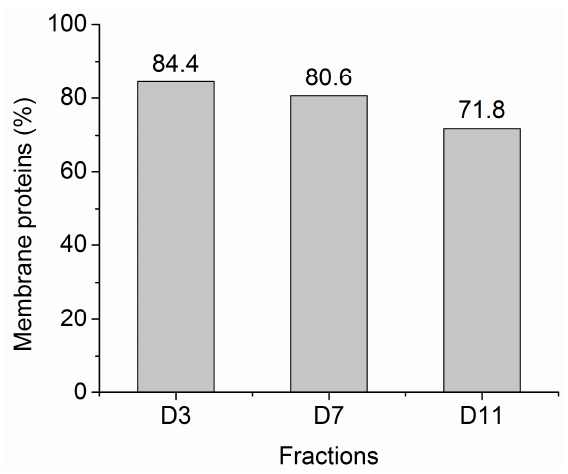
Figure 8. Percentage of membrane proteins identified from three fractions obtained from sequential pH-tuned ND fractionation of the proteins participating in the detergent-rich phase (D-phase). Protein cellular component classification is based on Gene Ontology provided by the UniProt Consortium (EMBL-EBI).